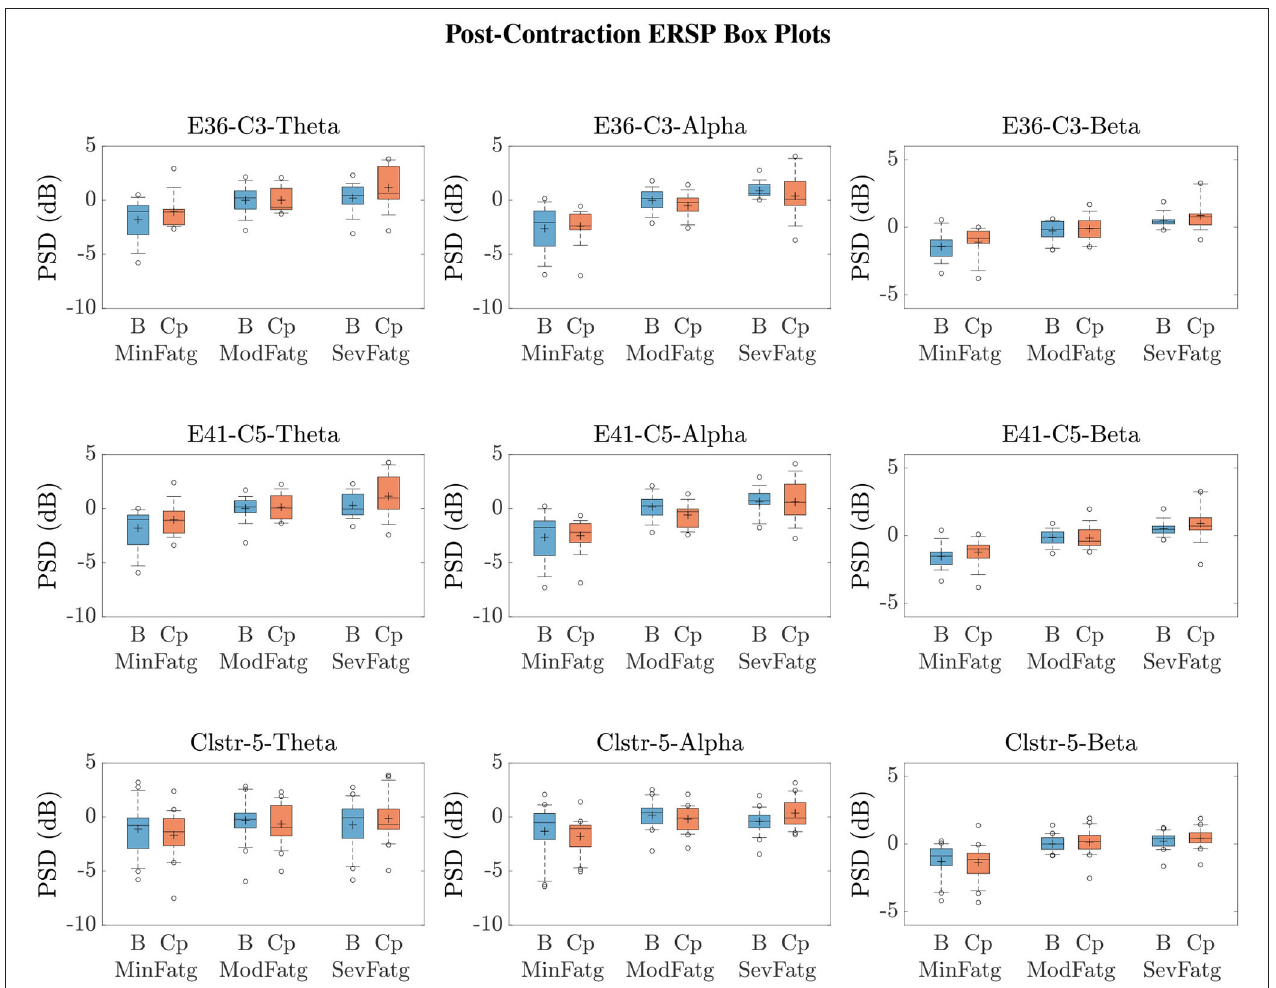
FIGURE 11 | Given a frequency band of interest, the PSD values were averaged over the post-contraction and the respective baseline interval. From the box plots of FatgCond FatgCond ≈ B and ≈ ERSP for the theta, alpha, and beta frequency band, one can infer that the band-specific time-averaged PSD scales with fatigue for C3 (row 1), C5 (row 2), and IC Cluster 5 (row 3) during the baseline (B) and post-contraction (Cp)